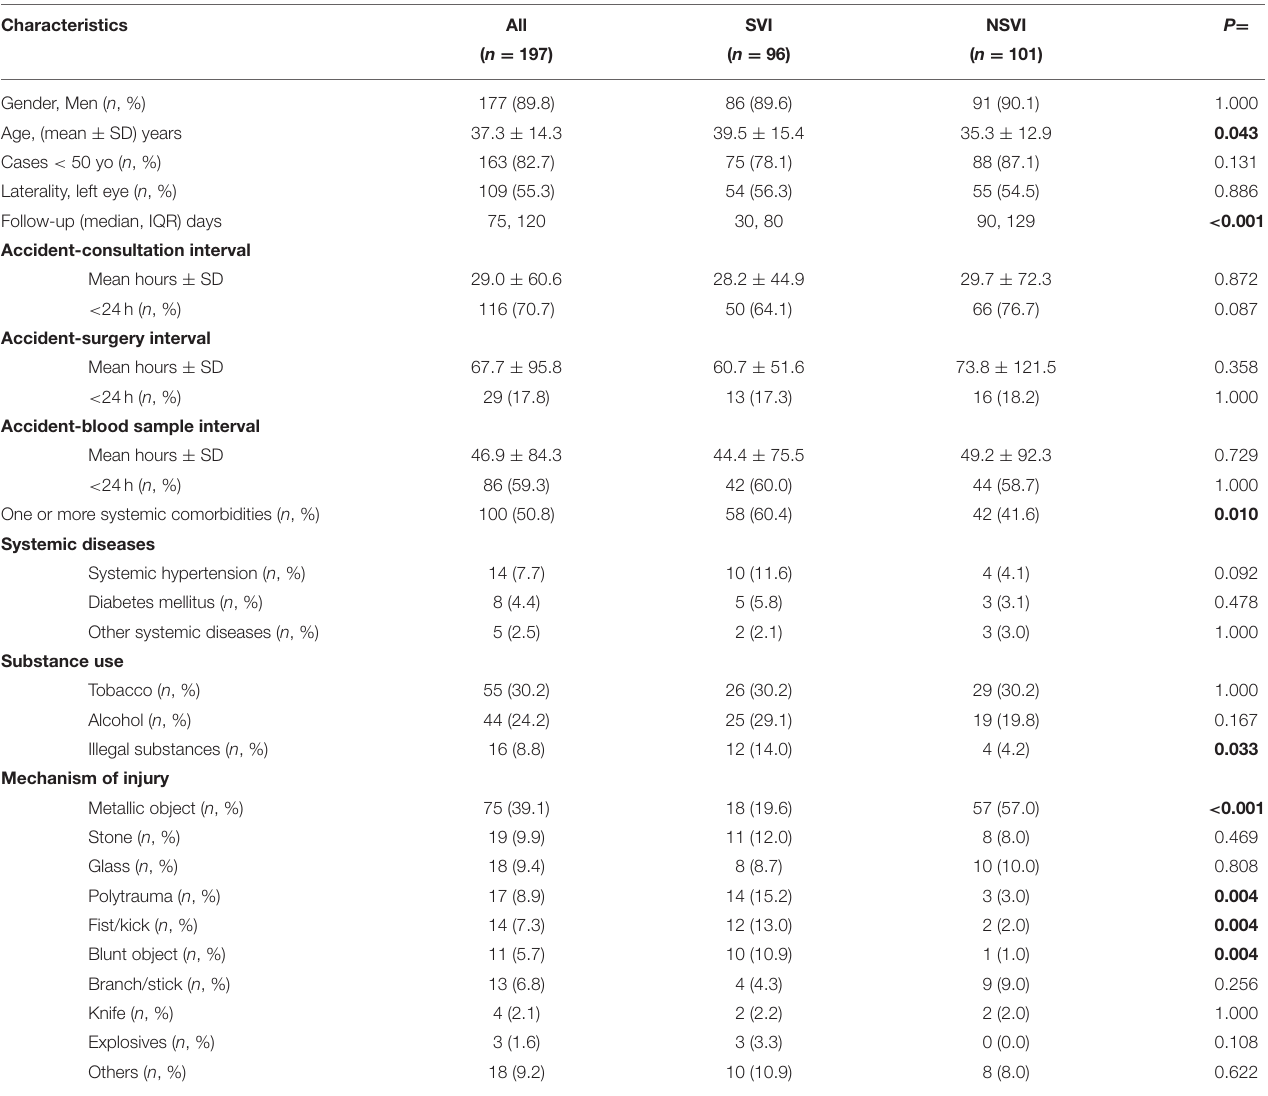
TABLE 1 | Demographics, time intervals and mechanism of injury in SVI and NSVI patients.